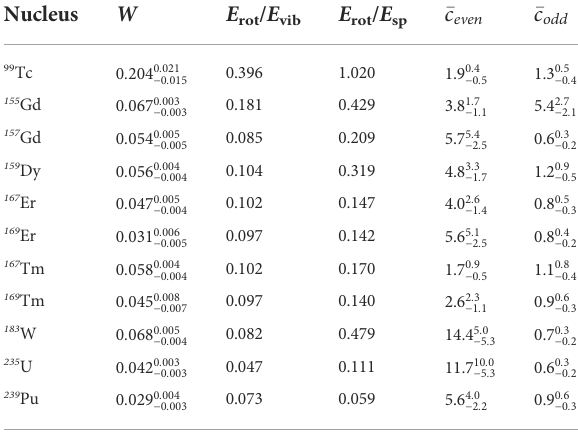
TABLE 2 The medianvalue of the error model parameters at N 4 LO and the estimated expansion parameters based on rotational and single particle energy scales. The uncertainties encompass the 16th and 84th percentiles of the samples in the marginalized distributions.